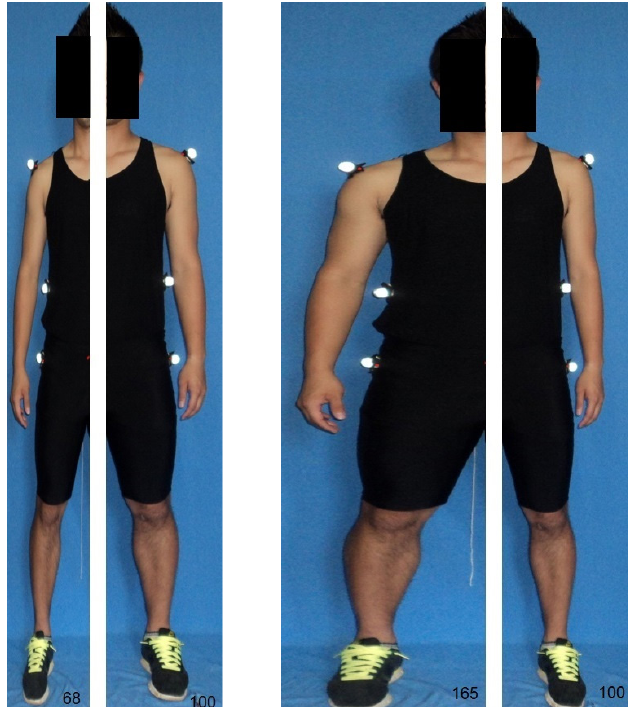
Figure 6. Two examples of pairs of images that are distorted on one side only (on right is the actual, undistorted image; on left is the dis- torted image). Male participant is from the control group (Braga,